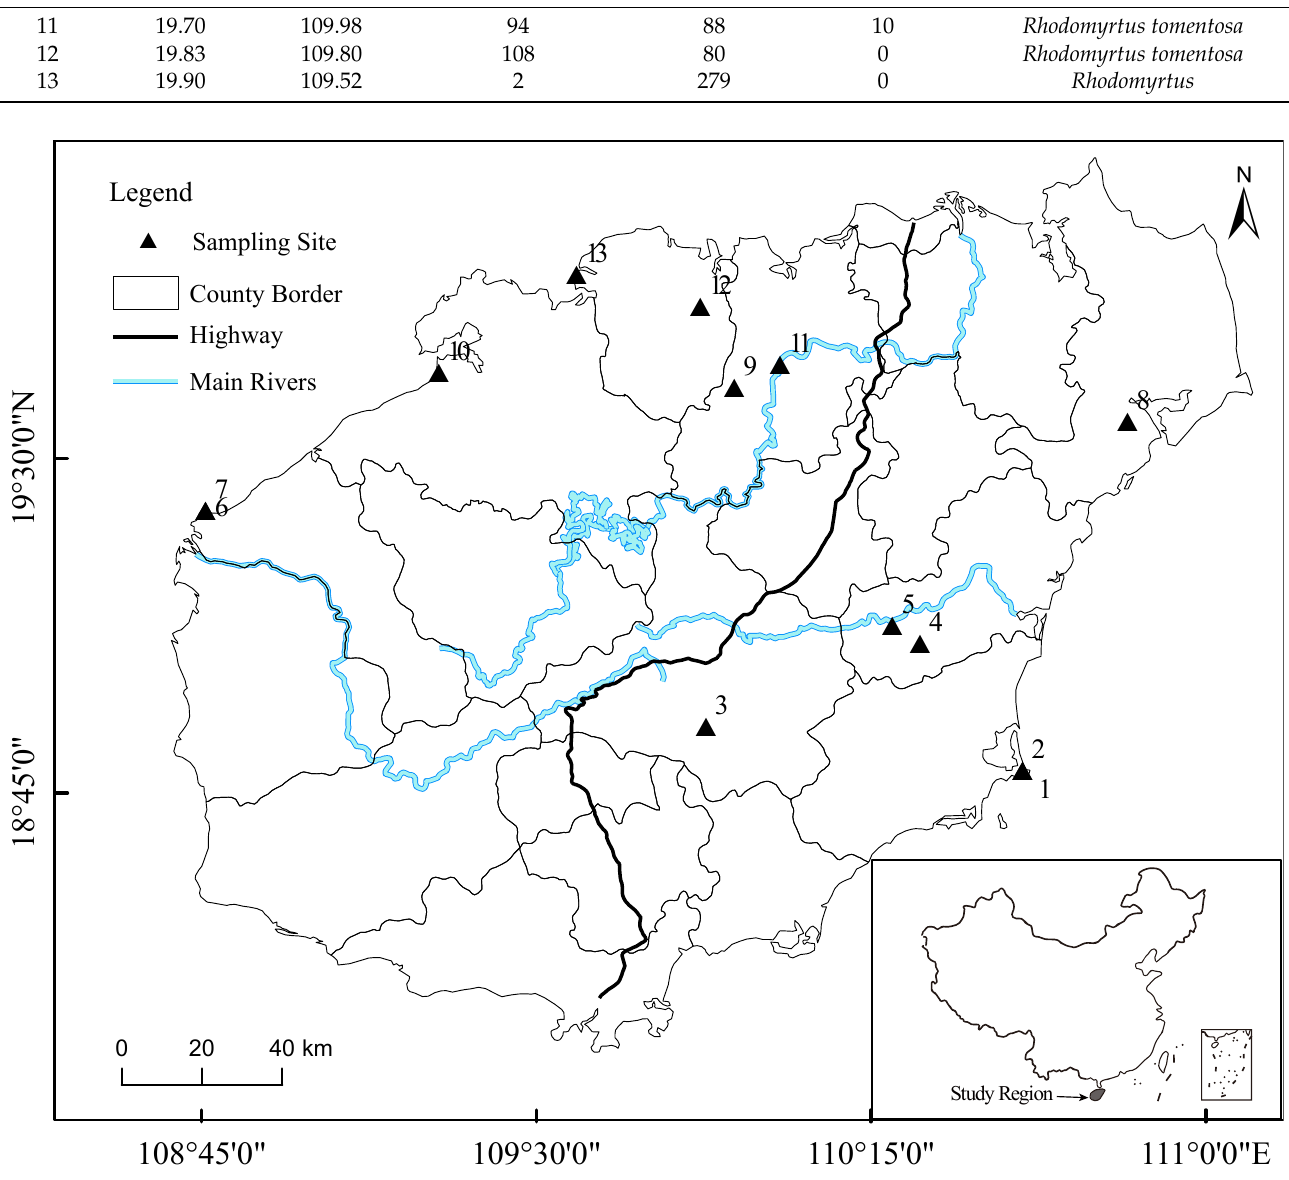
Figure 1. The distribution of sample plots. Note: The distribution of 13 sample plots in Wanning, Qiongzhong, Qionghai, Changjiang, Wenchang, Chengmai, Danzhou, and Lingao, Hainan, China. The specific information of the sample is listed in Table